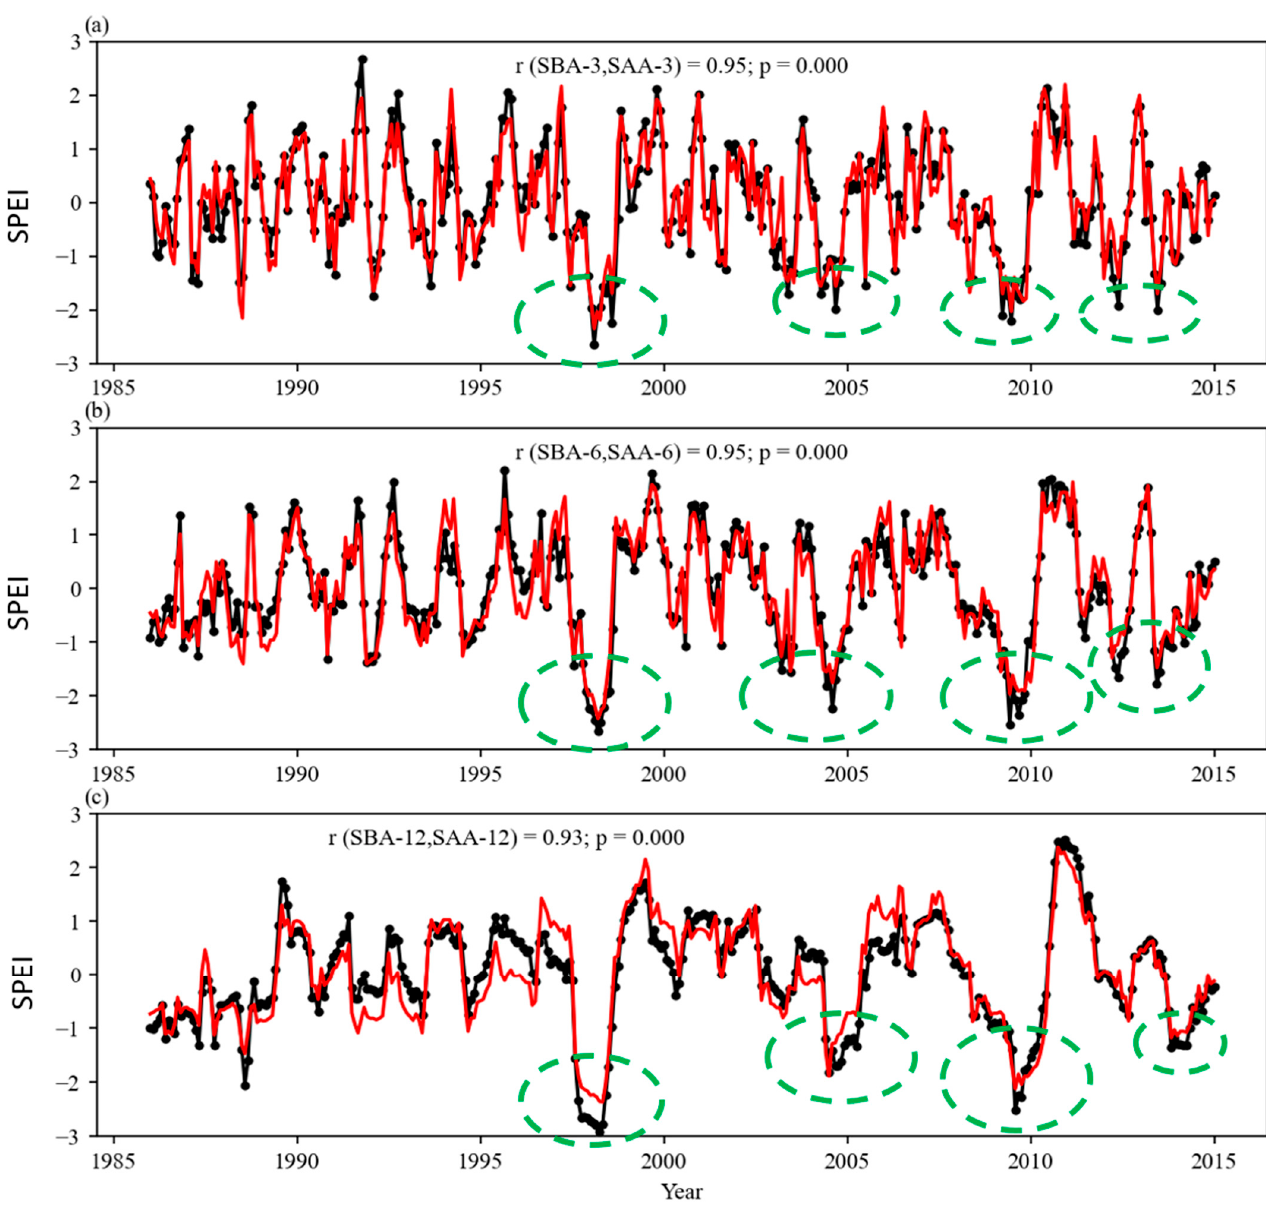
Figure 5. Average of SPEI from all stations (SAA) (black line) and that based on area average of climatic parameters (SBA) (red line) from 1986 to 2015 over Myanmar. The SPEI at the time scale 3-, 6- and 12-months are indicated in ( a ), ( b ) and ( c ), respectively. The p represents the significance of the correlation (r).